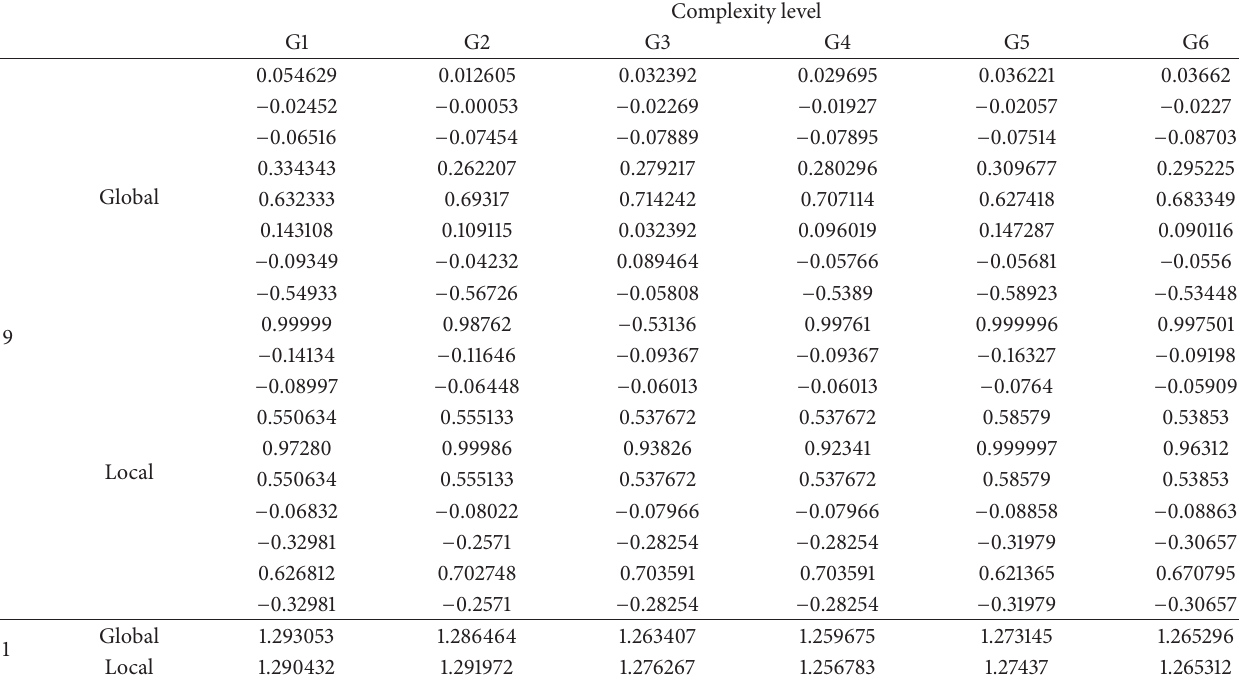
Table 6: Evolved wavelet libraries.